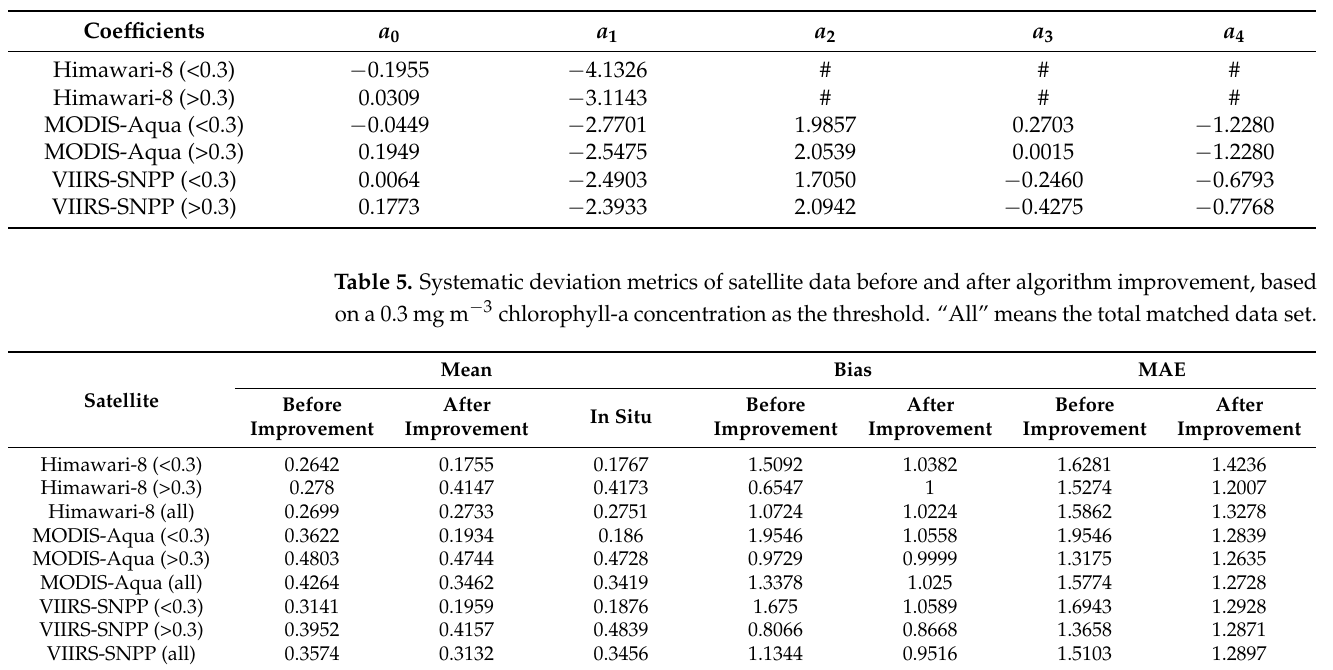
Table 4. New coefficients of the algorithms of the three sensors based on a 0.3 mg m − 3 threshold Chl-a concentration dividing the two groups.